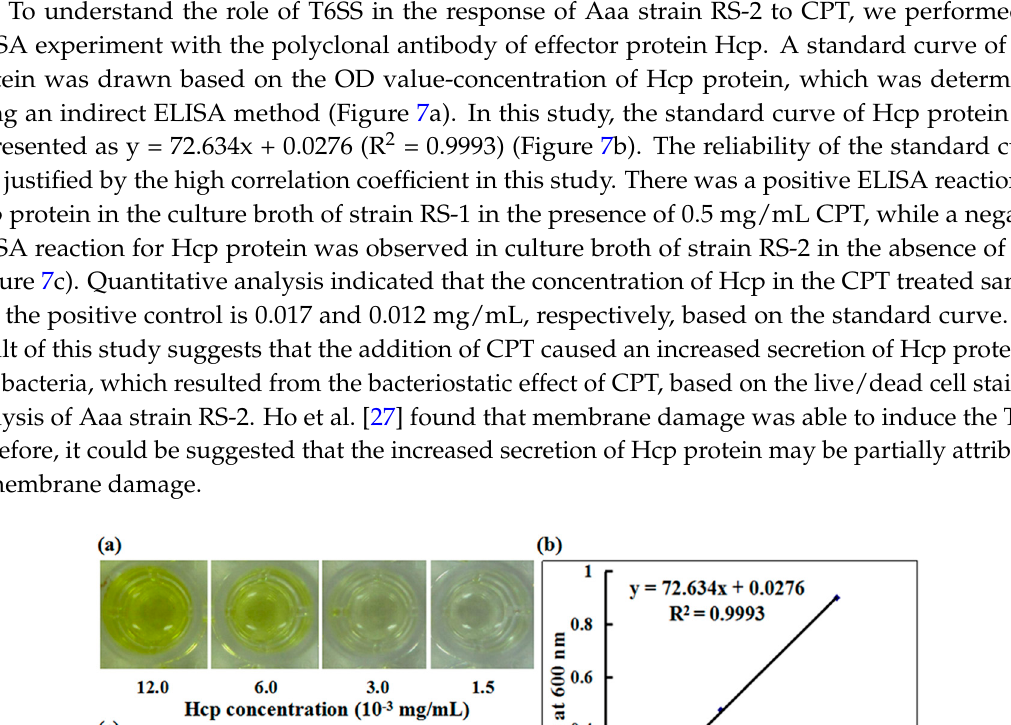
Figure 7. Effect of CPT on the secretion of Hcp protein. ( a ) ELISA of Hcp protein at different concentrations; ( b ) Standard curve; ( c ) ELISA measurement of Hcp secreted by CPT.